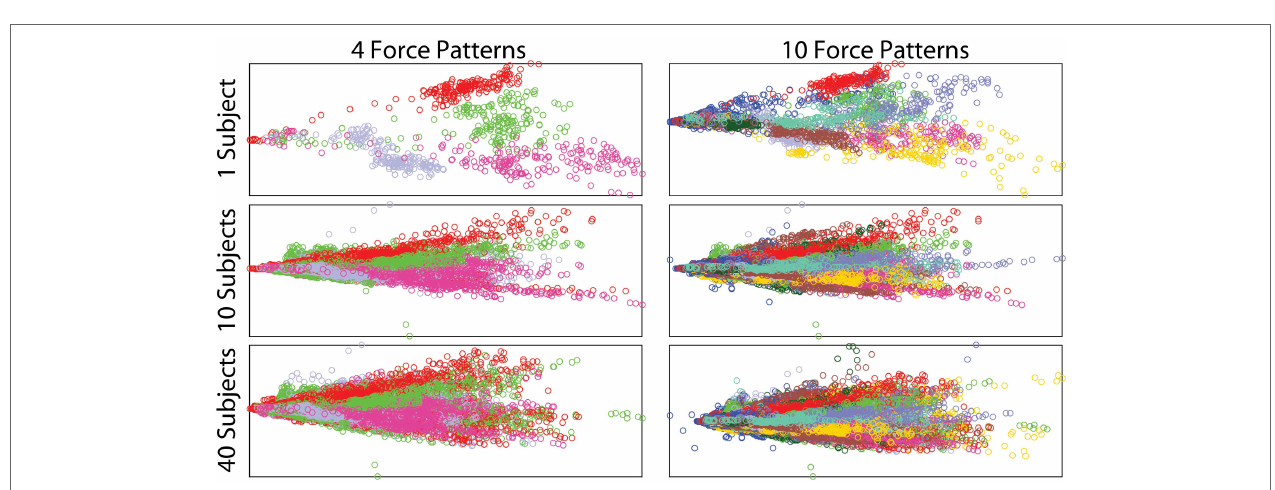
FIGURE 7 | Two principal components of the filtered sEMG signals, showing the effects of increasing the number of subjects and force patterns. Each color represents a different force pattern.